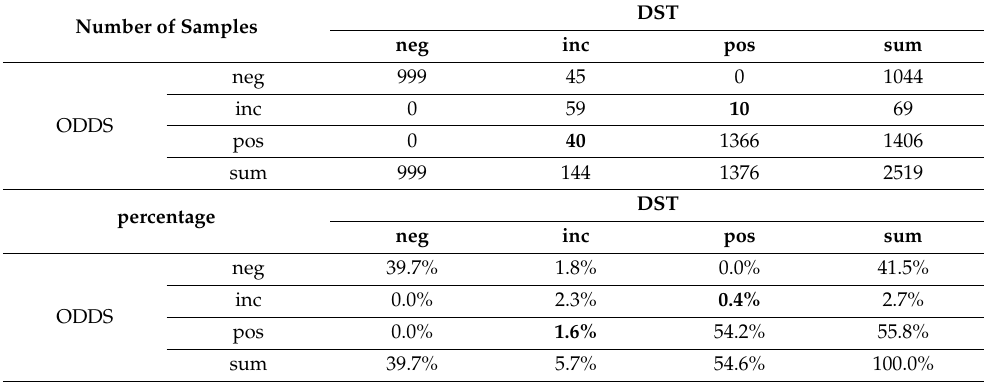
Table 1. Prediction by DST (Dempster–Shafer decision Theory) versus ODDS (conventional statistics). Predictions negative (neg), inconclusive (inc) and positive (pos). No samples are classified as fully contradicting (positive versus negative). Differences arise from samples predicted ‘inconclusive’: 144 (5.7%) via DST compared to 69 (2.7%) via ODDS. DST predicts more conservatively than ODDS. Cells with numbers in bold represent patients with ‘gain of information (10)’ and ‘gain of safety (40)’, respectively. As an overall measure of agreement we computed Cohen’s kappa: κ = 0.9287 [81]. DST Number of Samples neg inc pos sum neg 999 45 0 1044 inc 0 59 10 69 ODDS pos 0 40 1366 1406 sum 999 144 1376 2519 DST percentage neg inc sum neg 39.7% 1.8% 0.0% 41.5% inc 0.0% 2.3% 0.4% ODDS pos 0.0%